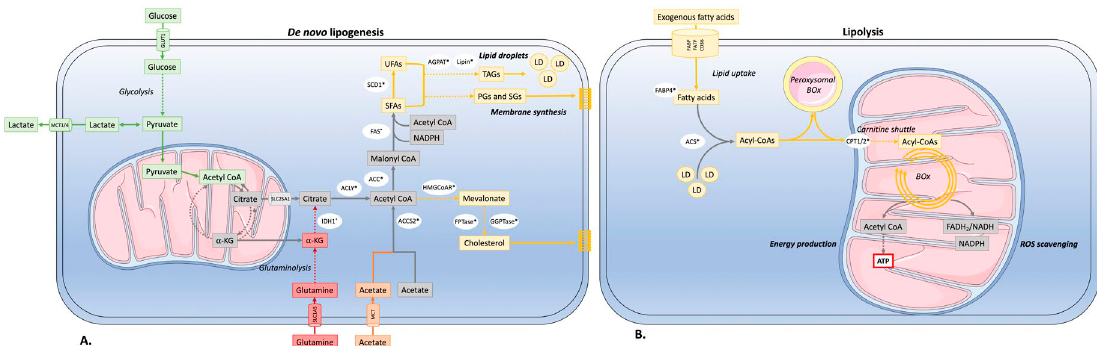
Figure 1. Simplified diagram of changes in lipid metabolism of cancer cells (see text for details) ( A ) De novo lipogenesis Glucose- and glutamine-derived citrate, which results from the increased glycolysis and glutaminolysis, is first converted to acetyl-coenzyme A (acetyl-CoA) by ATP-citrate lyase (ACLY). Acetyl-CoA can also be derived from acetate. Acetyl-CoA is then carboxylated to malonyl-CoA by acetyl-CoA carboxylase (ACC) and condensed by fatty acid (FA) synthase (FAS) in a repeat reaction to generate saturated FAs (SFAs) then desaturated by stearoyl-CoA desaturases (SCD1) into unsaturated FAs (UFAs). Synthesis of glycerolipids from long-chain FAs involved the enzymes 1-acylglycerol-3-phosphate acyltransferases (AGPAT) and lipin which are deregulated in resistant cancers. These lipids can be used for storage in lipid droplets, membrane biosynthesis, and signaling processes. Alternatively, acetyl-CoA can enter the mevalonate pathway to generate cholesterol. Key regulatory proteins dysregulated in resistant cancers are HMG-CoA reductase (HMG-CoAR), farnesyl prenyl transferase (FPTase) and geranylgeranyl prenyl transferase (GGPTase) ( B ) Lipolysis. FAs generated through the metabolism of triglycerides from lipid droplets (de novo synthesis) and from exogenous uptake constitute the pool of intracellular FAs that undergo fatty acid oxidation (FAO). Activation of FAs into acyl-CoA is catalyzed by Acyl coenzyme A (CoA) synthetase (ACS), then converted into FA carnitines by carnitine palmitoyl transferase 1 (CPT1) and broken down by mitochondrial β -oxidation (Box). Alternatively, peroxisomal β -oxidation catalyze the chain shortening of Acyl-CoA. FAO generates ATP production and participates to ROS scavenging through NADPH-producing reactions. Dysregulated enzymes altered in treatment-resistant cancer are indicated with an * (see text for